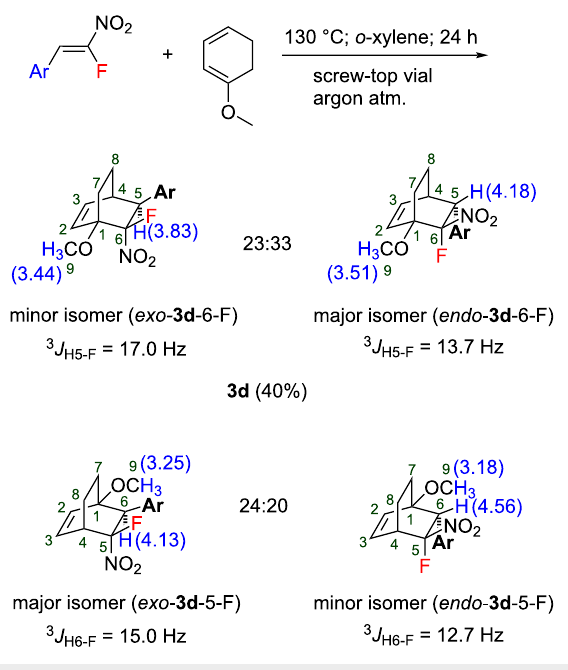
Figure 4: Kinetic curves for the reactions of nitrostyrene 1h with CPD (50–130 °C) and CHD at 110